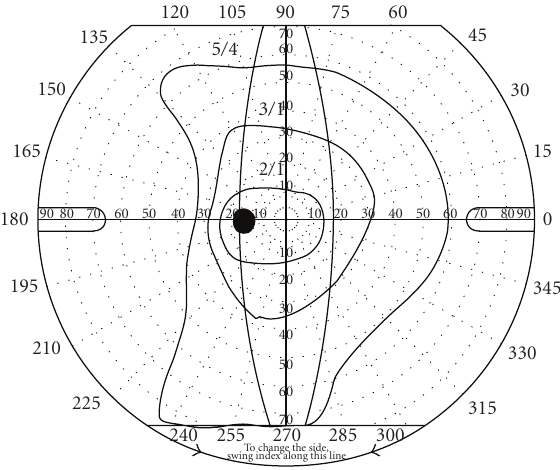
Figure 2: Goldmann visual field test seven months after surgery revealed a nearly complete temporal visual field defect in the left